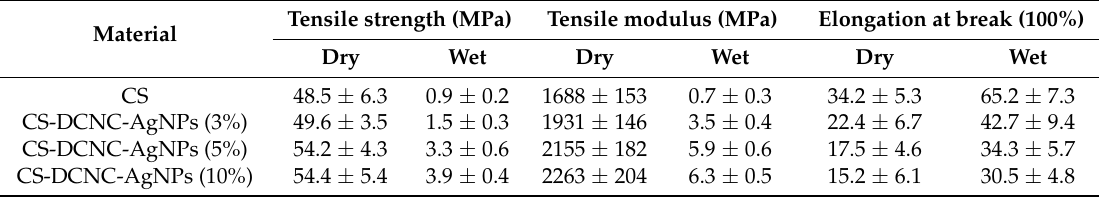
Table 1. Mechanical strength of